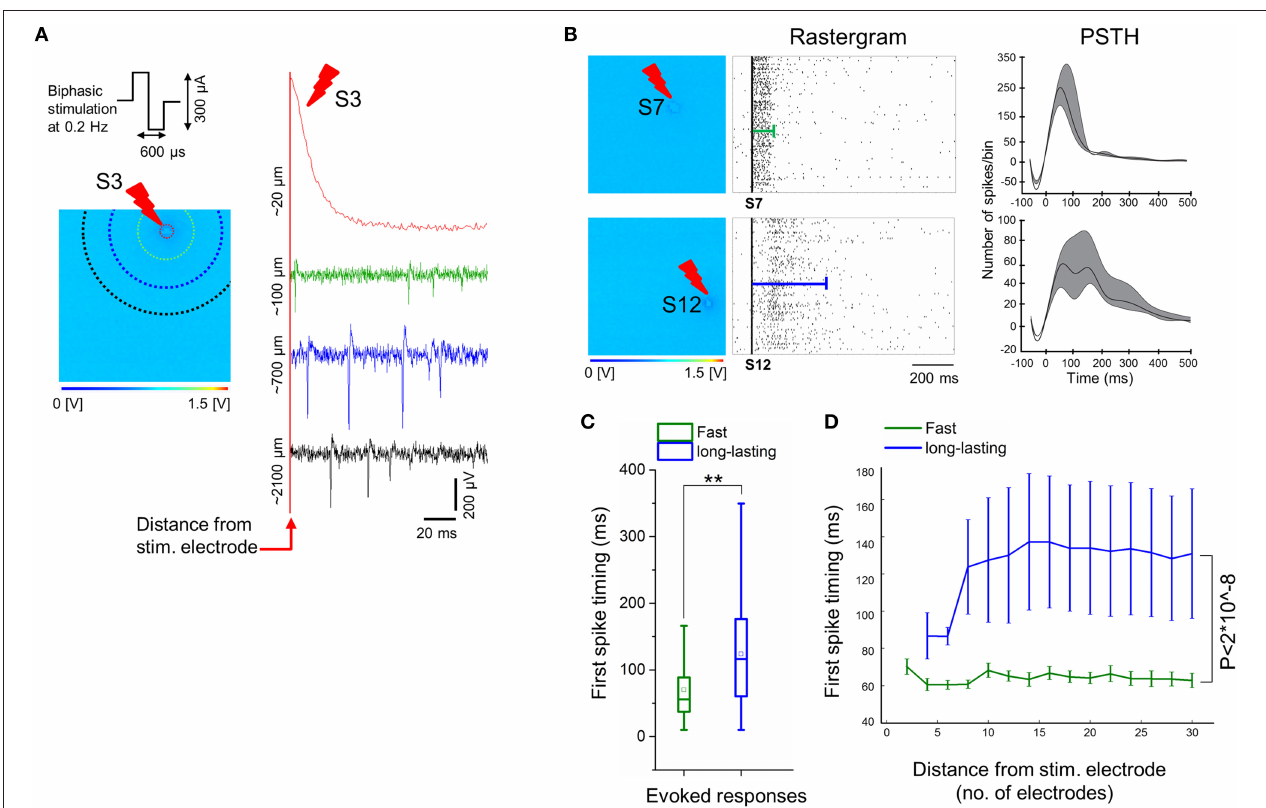
FIGURE 5 | Electrical stimulation delivered by electrodes on-chip show evoked responses only at 90DIV. (A) Sample of evoked signal traces illustrates the confined stimulation artifact to electrodes close to the stimulating electrodes ( < 100 µ m), e.g., when low-frequency (0.2Hz) trains of biphasic current stimuli (300 µ s per phase, peak-to-peak amplitude of 300 µ A) is delivered for 3min to exemplary electrode S3. Colors of signal traces correspond to the distance from the stimulating site, i.e., correlated with colors of dotted circles in the 64 × 64 array; for instance, the green response occurred at ∼ 6 electrodes distance ( ∼ 100 µ m) from the stimulating site, while blue at ∼ 15 electrode distance ( ∼ 700 µ m), and black trace at ∼ 26 electrode distance ( ∼ 2100 µ m). (B) Exemplary electrical stimuli (S7 and S12) delivered by specific electrodes on the 4096 electrode arrays (left) and their corresponding evoked responses by means of rastergram and PSTH analyses (middle and right, respectively). Two forms of evoked responses were observed and show, fast responses lasting < 100ms (top), and long-lasting responses up to ∼ 500ms (bottom). In the middle, rastergrams showing a sequence of evoked spikes that are confined within the green line (top), while evoked spikes are spread along the blue line (bottom). On the right, exemplary PSTHs that are computed from all evoked activities corresponding to their stimulating electrodes (see Materials and Methods). This shows that fast responses are characterized by a higher number of spikes per 25ms bin size and lasting < 100ms, in contrast with a lower number of spikes per bin and duration up to ∼ 500ms in case of long-lasting responses. Note that the negative tough in the PSTH is determined by the adopted artifact removal and smoothing procedures. (C) Average of the first spike timing delays with respect to electrical stimulation computed from two-group responses (fast vs. long-lasting). A delay of about 70ms is observed from fast responses (green), while the onset of long-lasting responses (blue) occurred significantly over a longer period, i.e., 120ms ( n = 3 , ** p < 0.01 ). (D) The average of first spike timing is measured with respect to the distance from the stimulation site, by starting from four electrodes ( ∼ 50 µ m) until 30 electrodes ( ∼ 2827 µ m) after stimulus. This indicates that the first spikes in case of fast responses (green) occur within ∼ 60–70ms after stimulation, regardless of their distance from the stimulus, whilst, first spikes in long-lasting responses (blue) begins at ∼ 85ms, in close proximity to the stimulus (within four electrodes distance), and delayed to 120–140ms in the distant ones. Non-significant differences of first spike timing between response (fast vs. long-lasting) and distance in µ m (5, 10, 15, 20, 25, and 30) were determined by two-way ANOVA ( p > 0.05 ). Responses of both groups (fast vs. long-lasting) are highly significant over the entire computed distance, i.e., ∼ 2827 µ m. ( n = 3 , p < 2*10 ∧− 8 , two-way